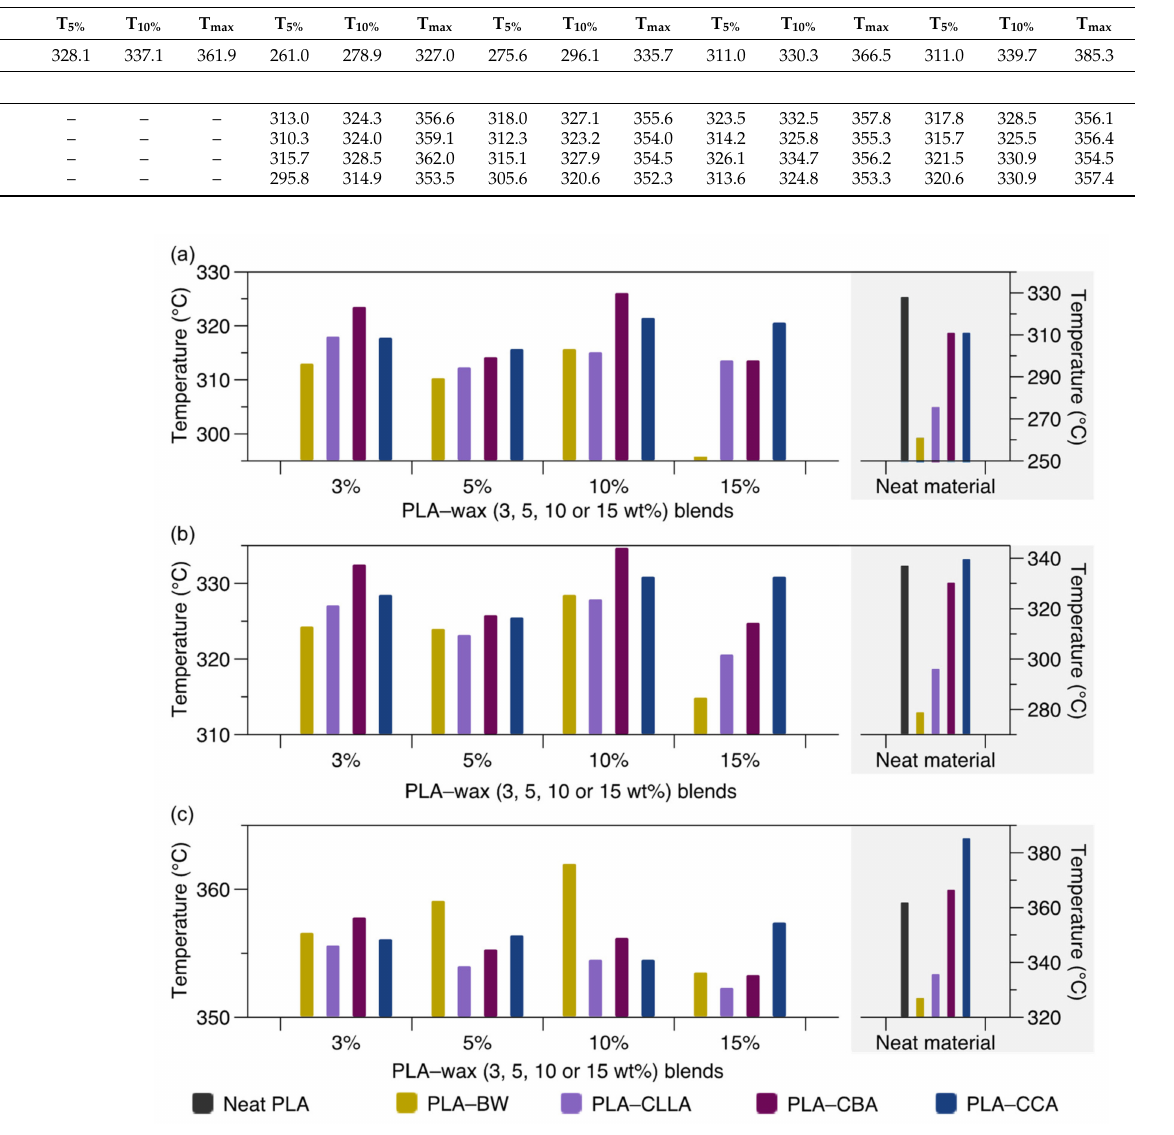
Figure 1. ( a ) Degradation temperature at 5% weight loss. ( b ) Degradation temperature at 10% weight loss temperature, and ( c ) maximum degradation temperature of neat polylactic acid (PLA), wax (beeswax (BW), candelilla (CLLA), carnauba (CBA), and cocoa (CCA)) and PLA–wax (BW, CLLA, CBA, and CCA)) blends and their respective neat